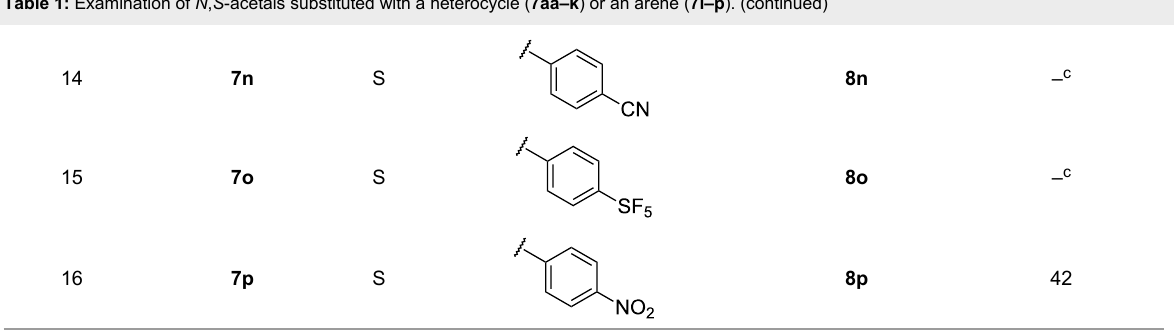
moiety. The reduced inductive effect of the amine might be at- tributed to the resonance structures of imidazole (Table 1, entry 11)